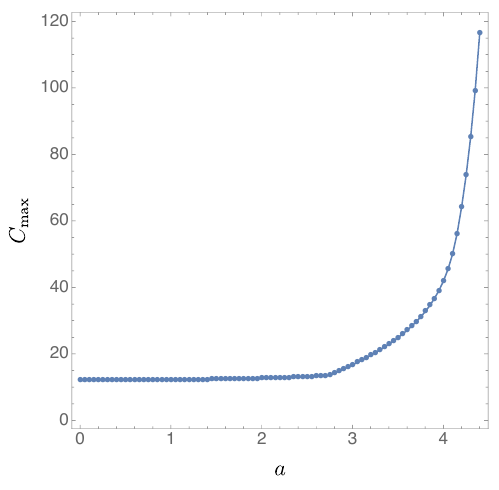
Figure 13 . C max as a function of a , computed for n = 4 and T = : 9 = 4 (cid:25)